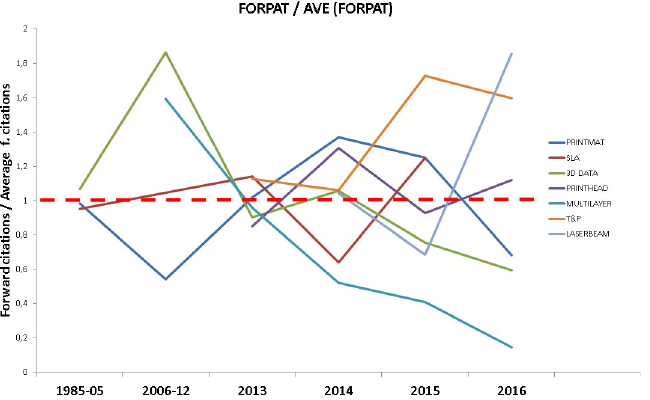
Fig 12. FORPAT for each technology front. Evolution of the FORPAT indicator for each technology front, normalized. Points above the red dashed line indicate higher than average forward citations.